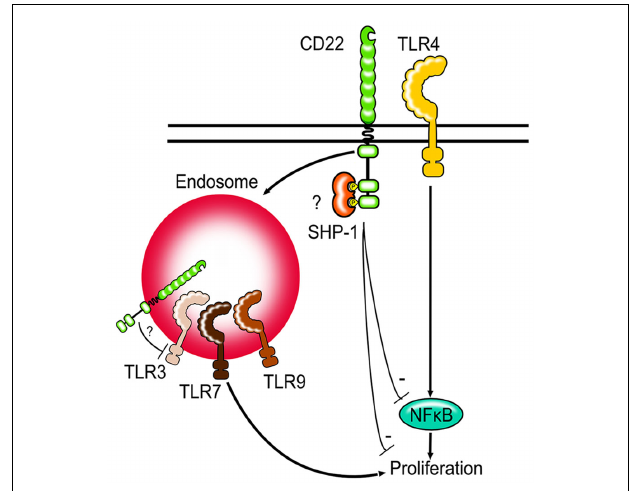
FIGURE 2 | Siglecs andTLRs. Siglec-G and CD22-deficient B cells show increased proliferation afterTLR stimulation. First evidence suggests that CD22 might be able to regulate NF κ B activity afterTLR stimulation. CD22 can be internalized by endocytosis and may be in direct contact to TLRs found in endosomes.Whether Siglec-G can limitTLR signaling via modulating NF κ B activity in B cells is not known.